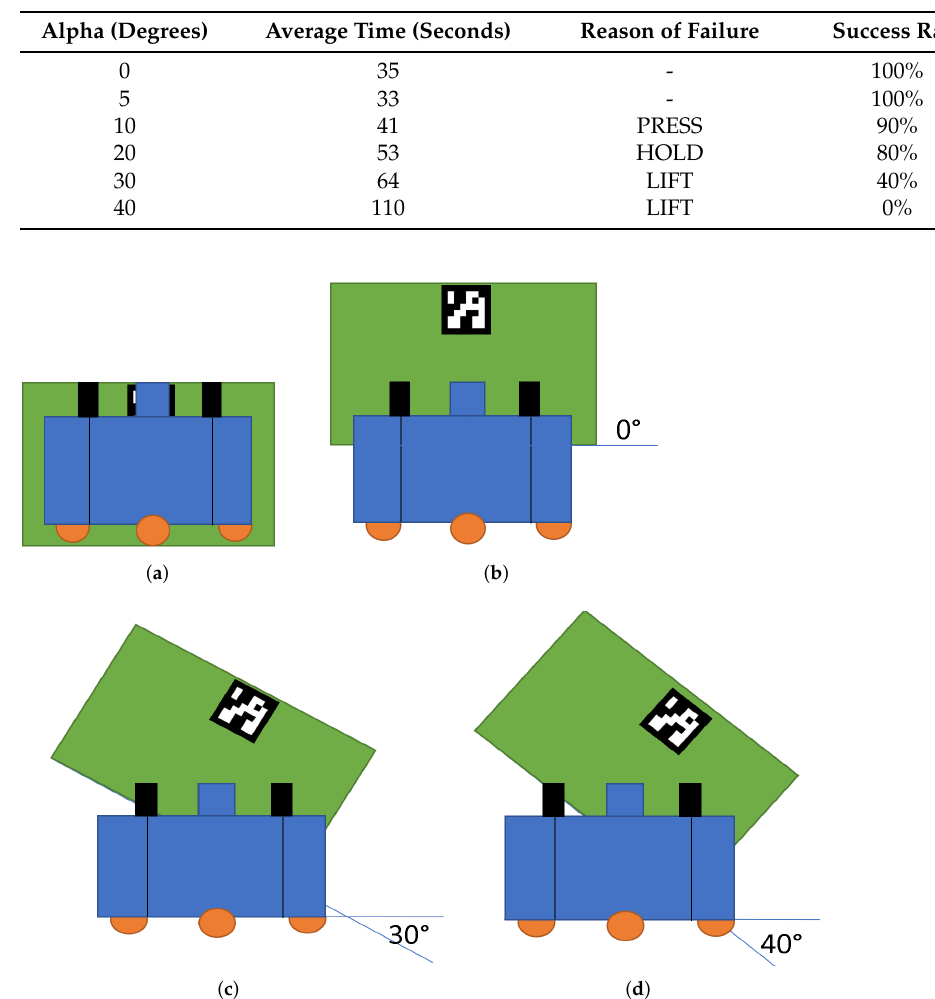
Figure 8. Lifting angle limitation: ( a ) ready to lift; ( b ) lifted (alpha = 0 deg); ( c ) lifted (alpha = 30 deg); and ( d ) failed to lift (alpha = 40